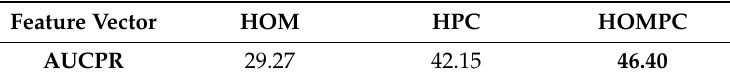
Table 4. AUCPR (%) results for HOM, HPC, and HOMPC.